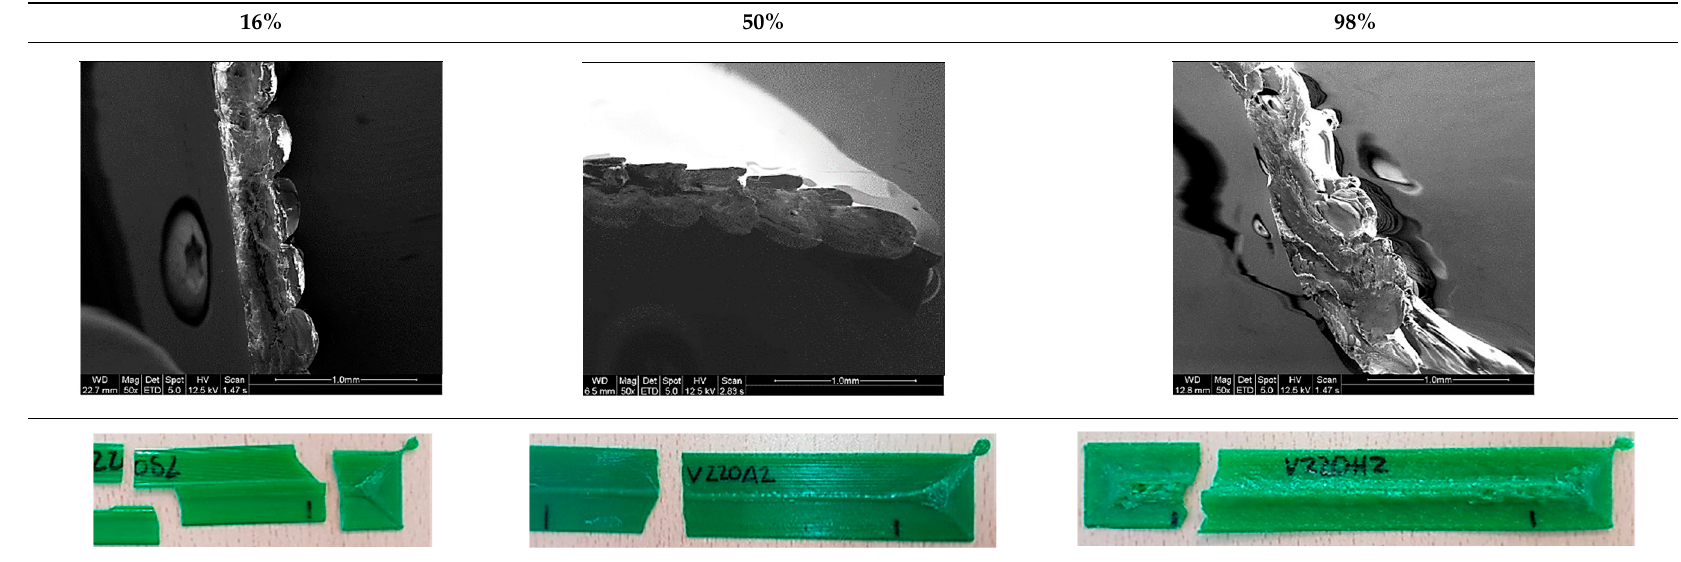
Table 5. SEM section of monolayer specimens subjected to tensile tests.